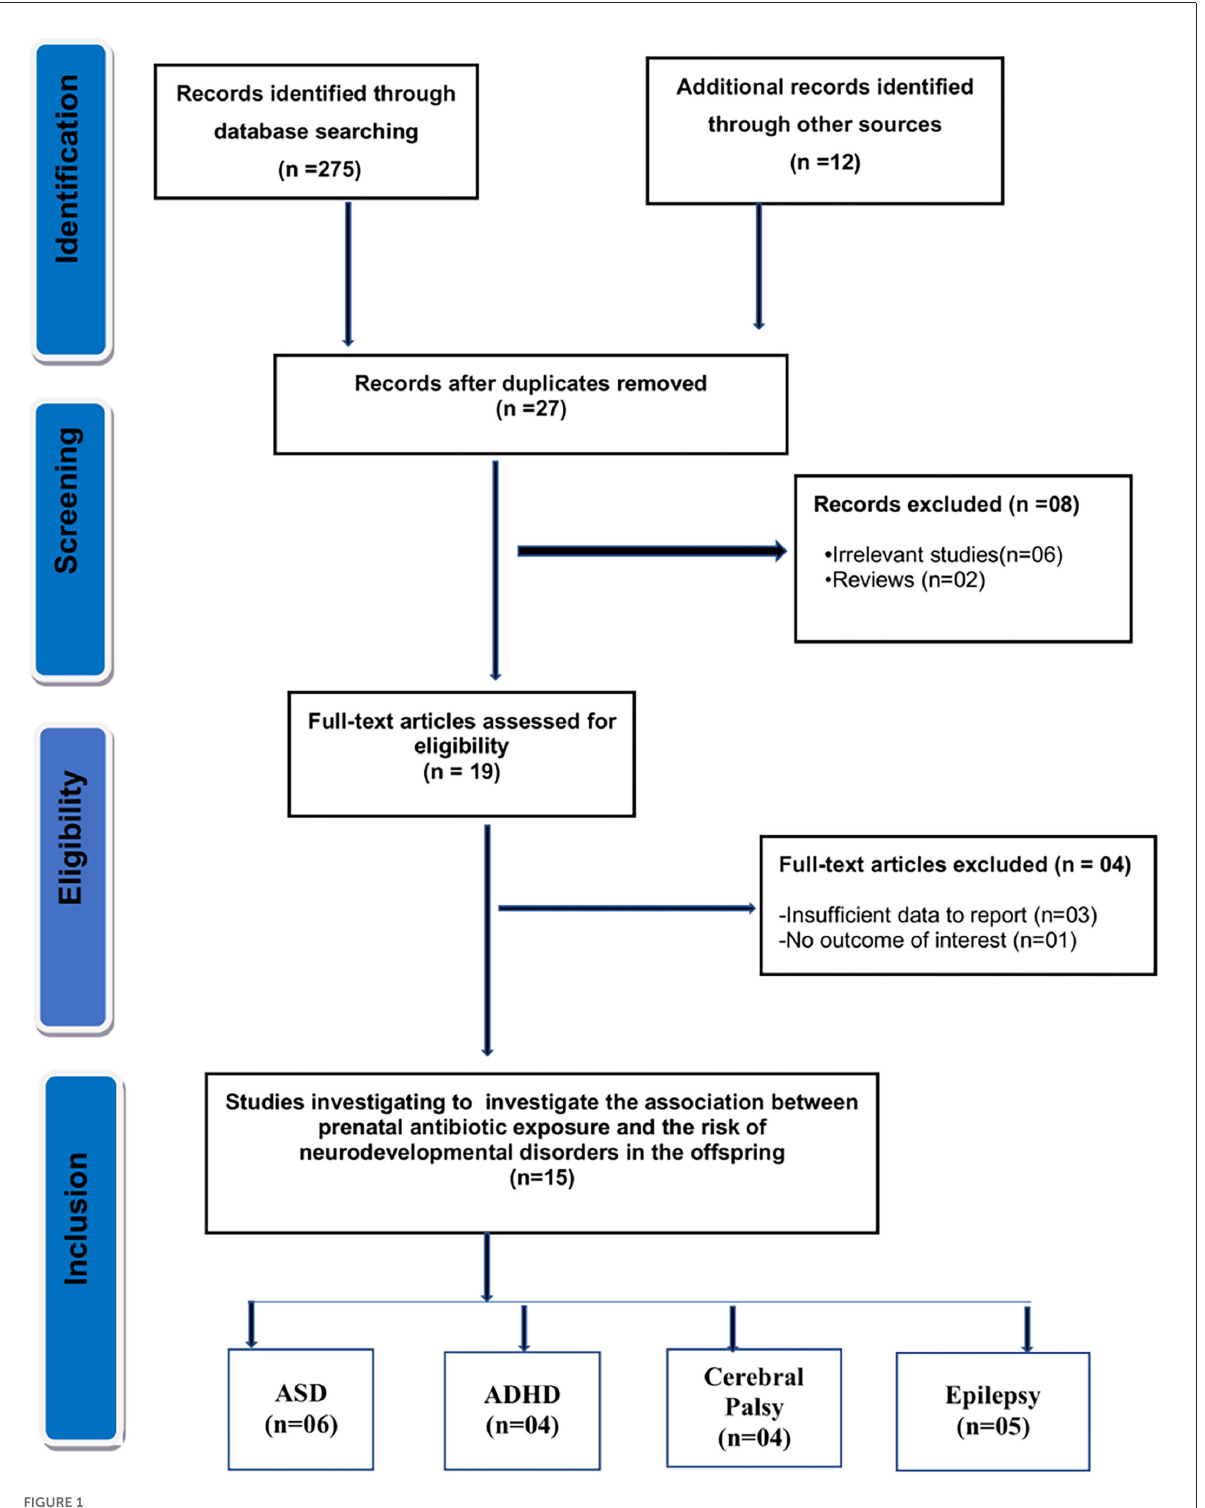
FIGURE1 Flow diagram for the selection of studies and specific reasons for exclusion from the present